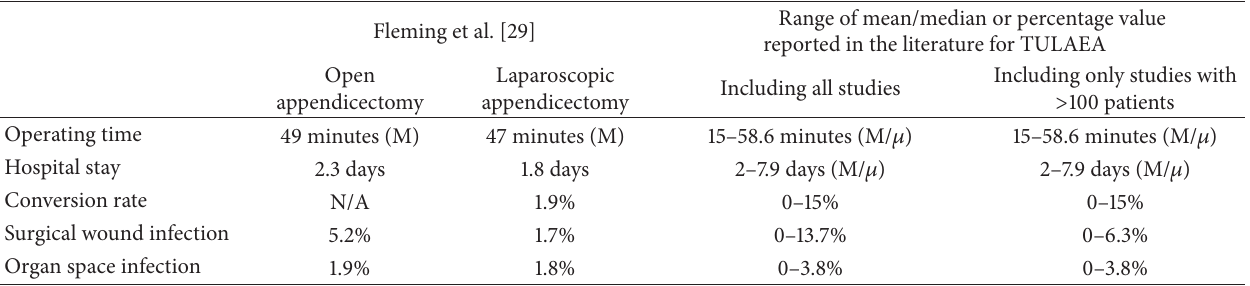
Table 3: Comparison of outcomes with College of Surgeons National Surgical Quality Improvement Program (NSQIP) database for 2005 to 2008, data published by Fleming et al.